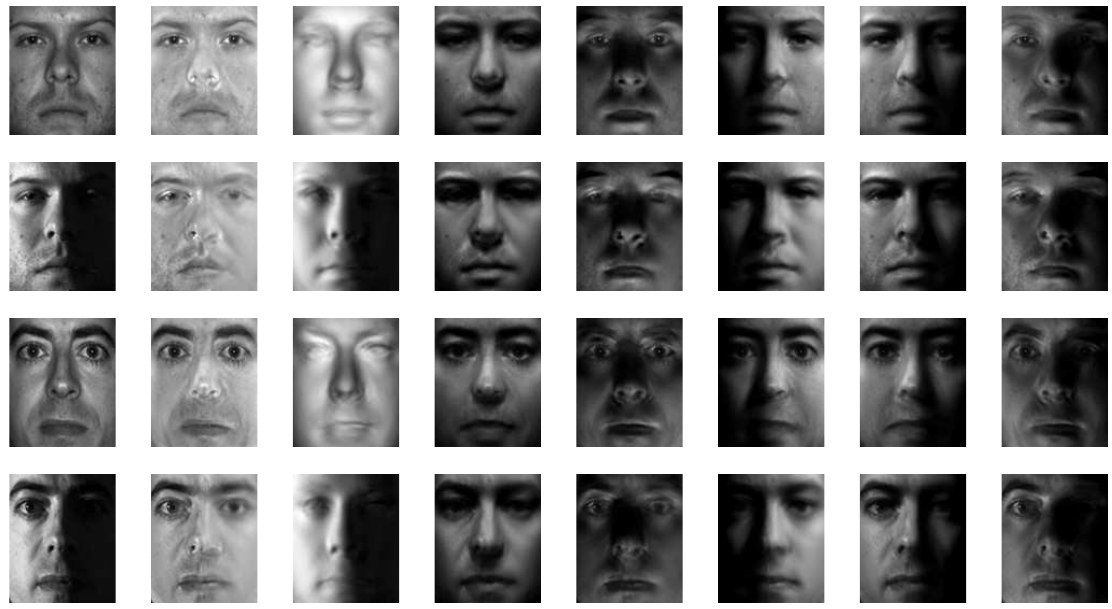
Figure 5. Relit images based on the Yale database (1st column: input image; 2nd: recovered texture; 3rd: estimated illuminance; and 4–8th: relit images).